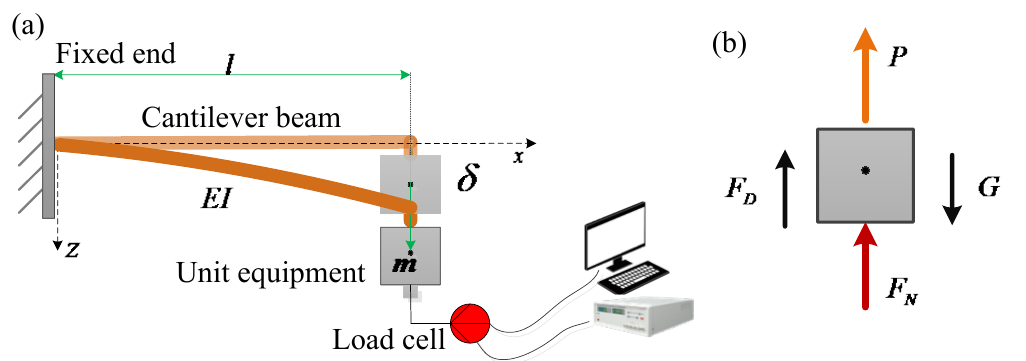
Figure 2. Unit equipment weighing system with equivalent cantilever beam: ( a ) the simplified model of the system; ( b ) the force diagram of unit equipment.